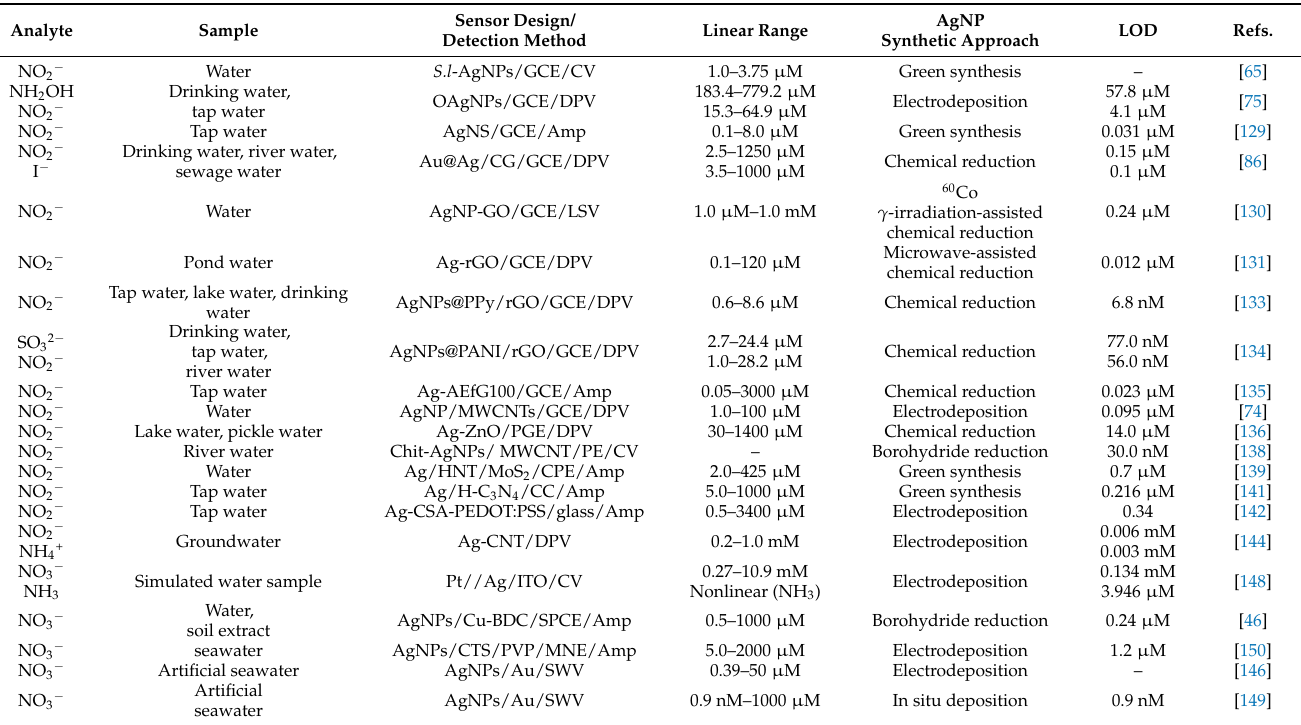
Table 2. Survey of the reviewed silver nanomaterial-based electrochemical sensors for detection of nitrogen-containing inorganic water